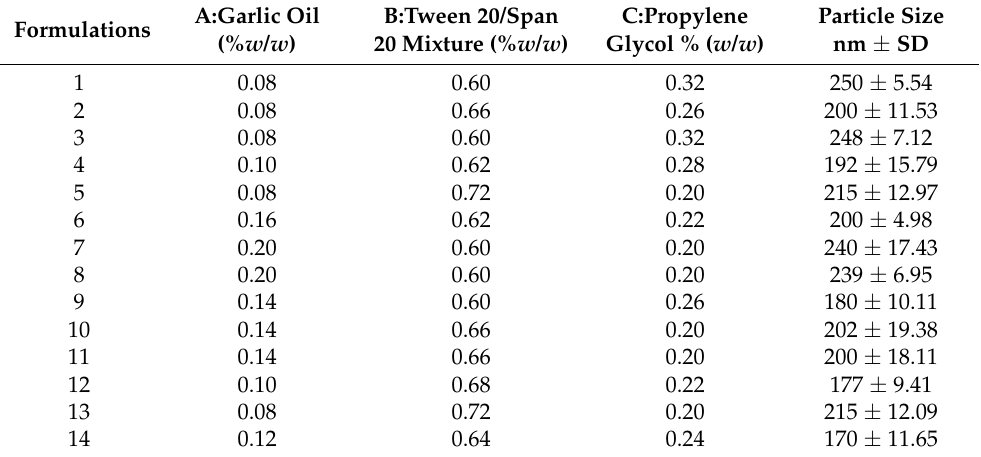
Table 1. Observed response of formulations prepared for optimization of acyclovir (ACV)-garlic oil (GO) self-nanoemulsifying drug delivery system (SNEDDS) (Data are expressed as mean ± SD ( n = 3)). A:Garlic Formulations